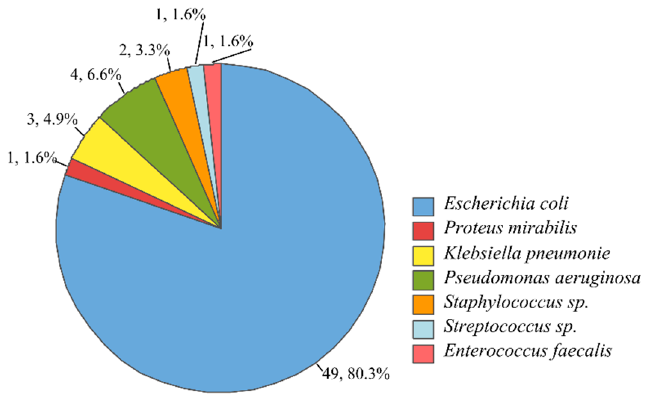
Figure 1. Bacterial isolates from urinary tract infection (UTI) patients and presumptive identification based on biochemical tests. For each group, the number of isolates and the respective percentage is included in the figure as a